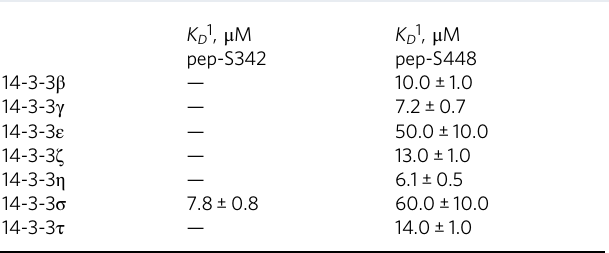
(Fig. 3c). The binding af fi nities of our singly phosphorylated variants correlate with previous observations of their relative contribution to the cAMP-dependent regulation of Nedd (Ser 448 >